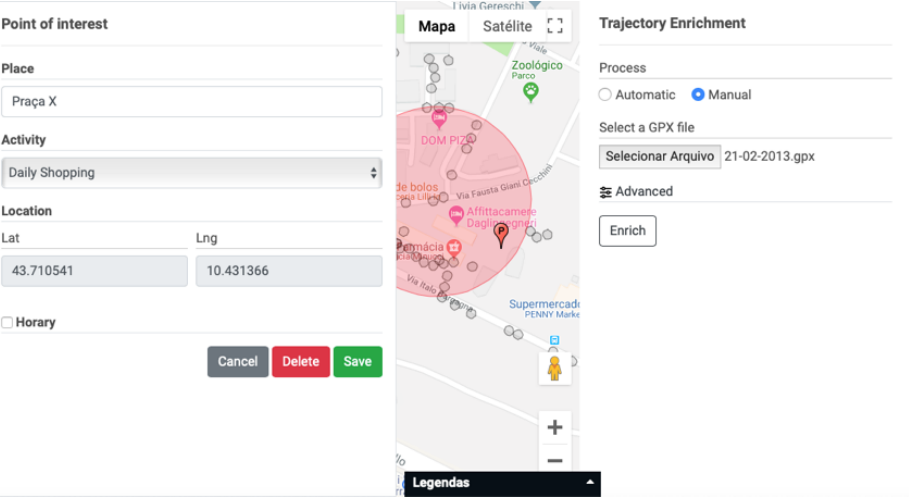
Figure 10. Interface of the Manual Semantic